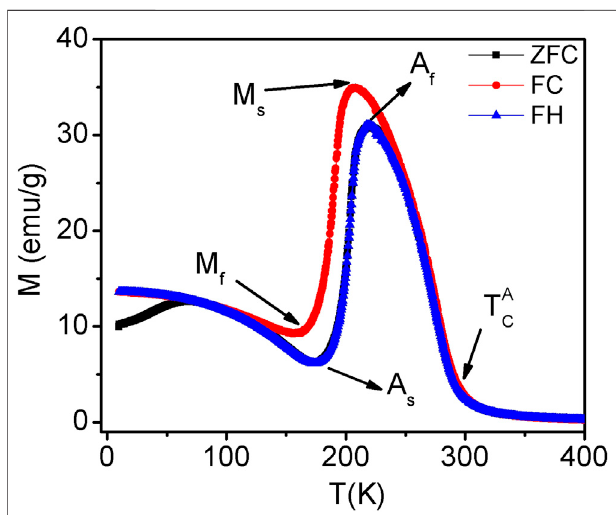
FIGURE 5 | The ZFC, FC and FH, magnetization as a function of temperature (M-T) curves measured at 1 kOe fi